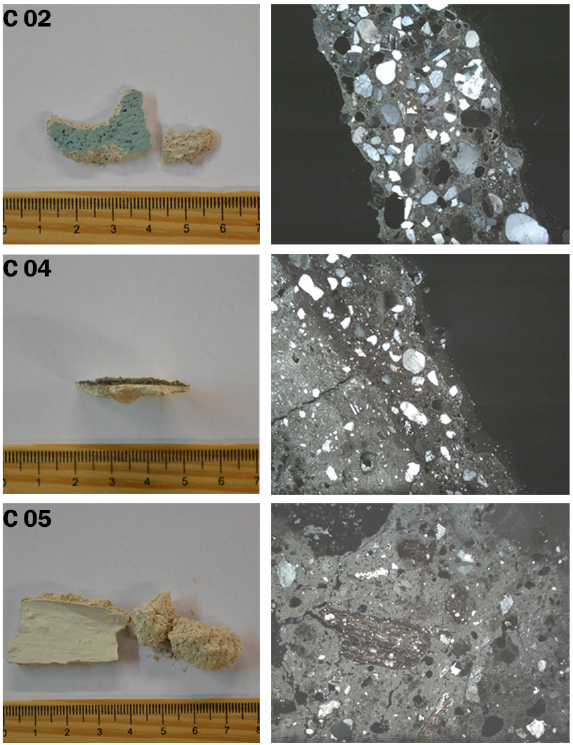
Figure 6. Minero-petrographic analysis. From the left: macro photo; thin sections under the optical microscope in Transmitted Light (Laboratory analysis: Grillo S.M., LabMaST. Graphic elab: Pilia E.).